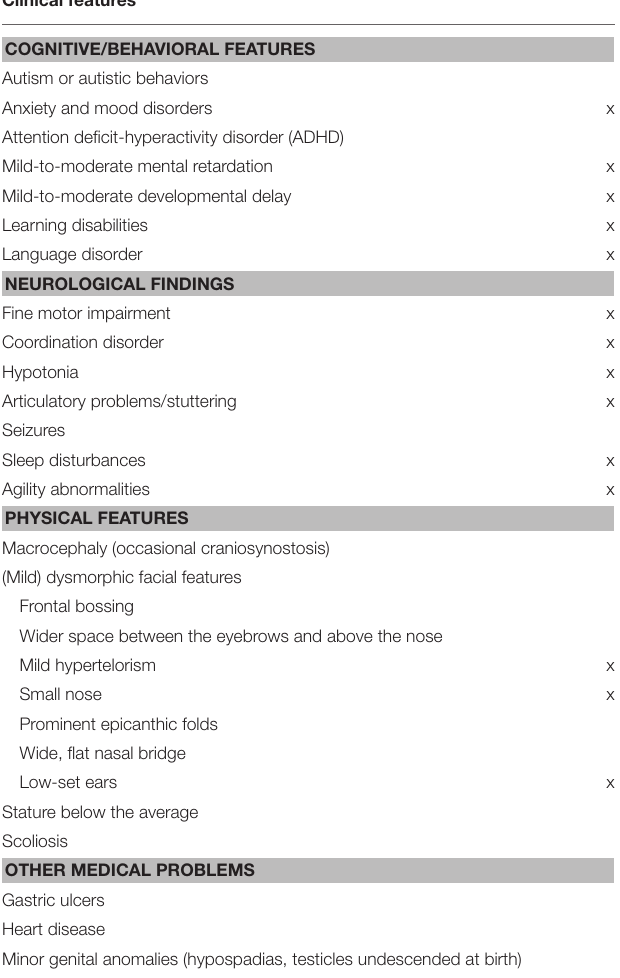
TABLE 1 | Summary table with the most relevant clinical features of our proband compared to other patients with the 1q21.1 microduplication syndrome [source: Unique (https://www.rarechromo.org/), (1, 2, 4)]. Clinical